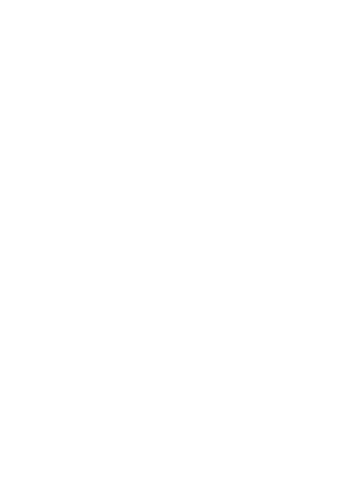
started from the national capital and radiated to the provincial capitals in different directions,